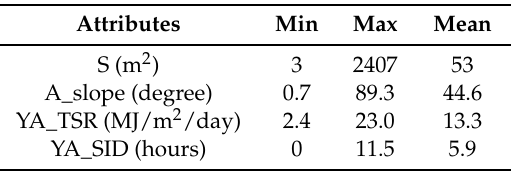
Table 3. The minimum, maximum, and mean value for roof plane attributes in the Lujiazui region.